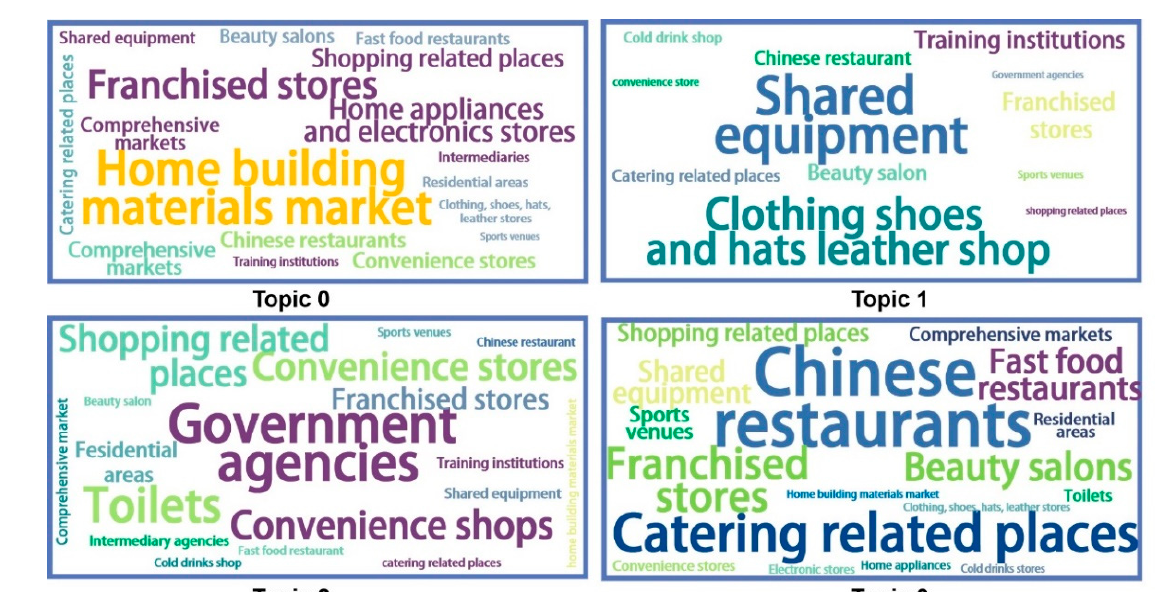
Figure 4. LDA comparison word cloud.